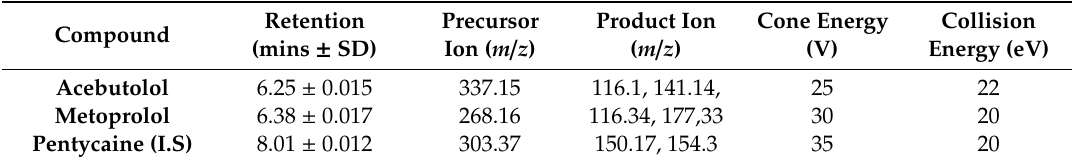
Table 1. Optimized liquid chromatography tandem mass spectrometry (LC / MS / MS) parameters for the studied